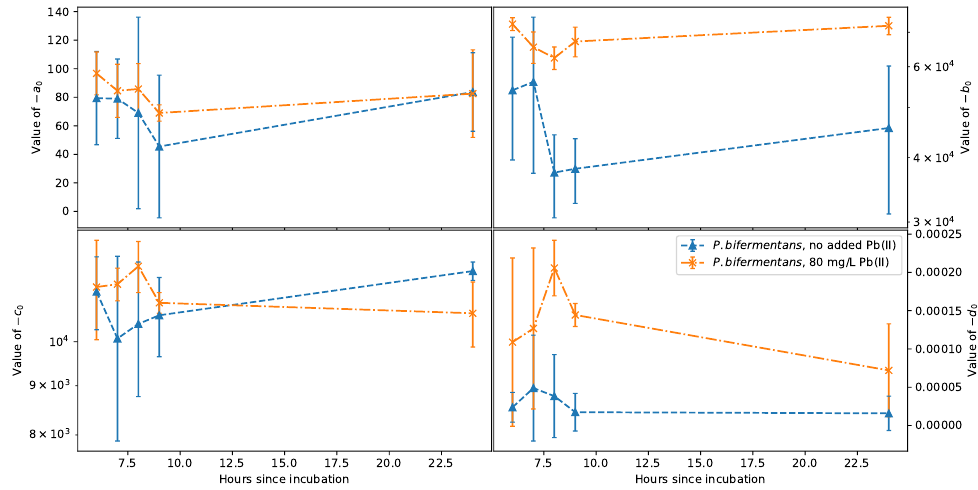
Figure 8. Change over time of the fit parameters a 0 , b 0 , c 0 , and d 0 for P. bifermentans . Similar to K. pneumoniae , Figure 8 for P. bifermentans shows very little change in d 0 over the measured growth period, which is suspected because this parameter is related to